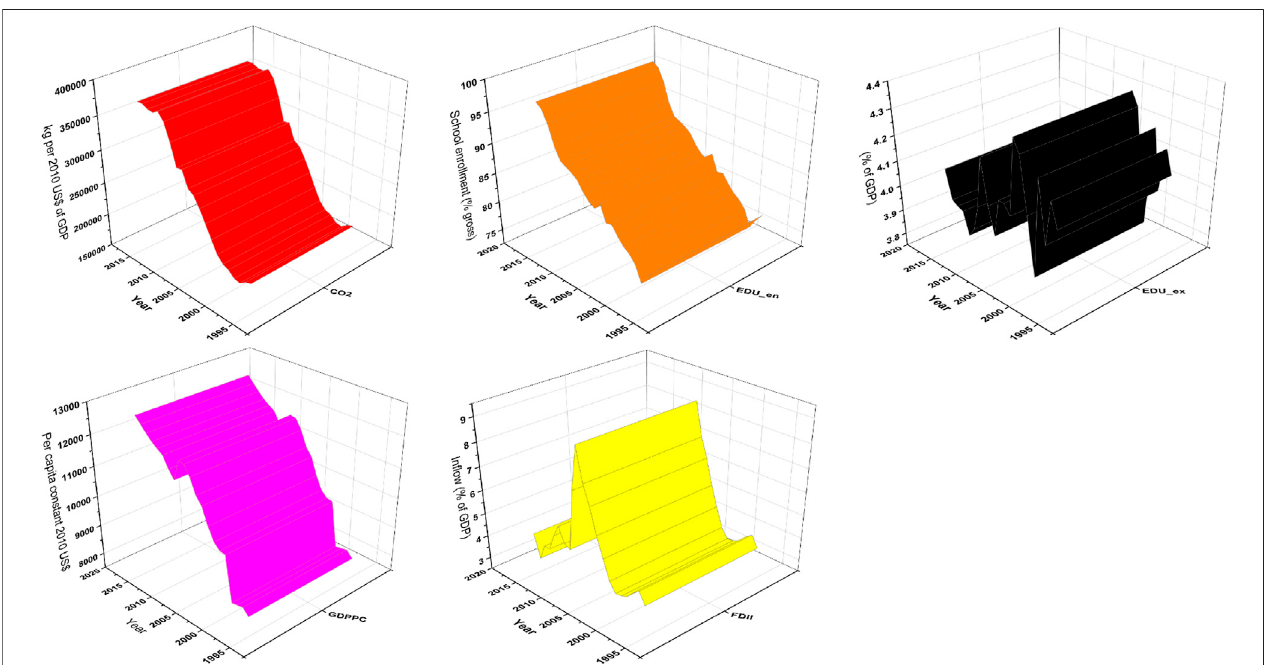
FIGURE 2 | Yearly average CO 2 , EDU_en, EDU_ex, GDPPC and FDII in BRI countries.